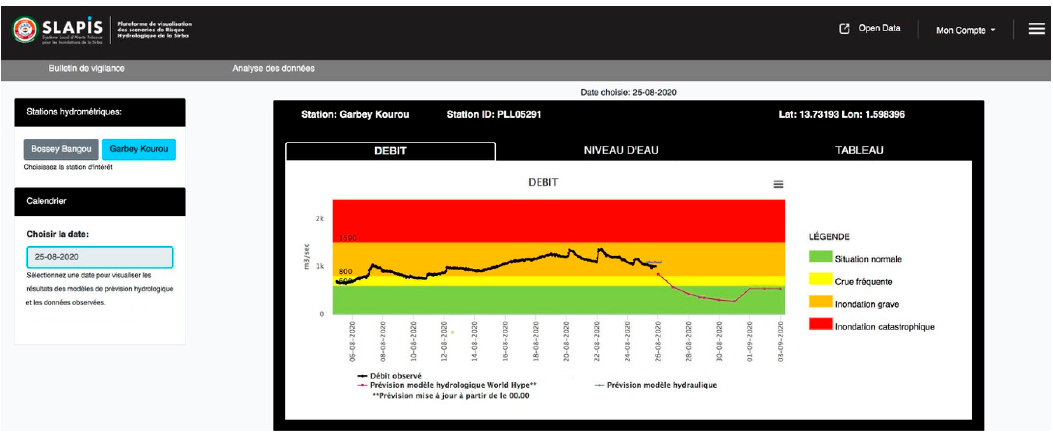
Figure 8. WWH forecasts data flow in SLAPIS spatial data infrastructure.